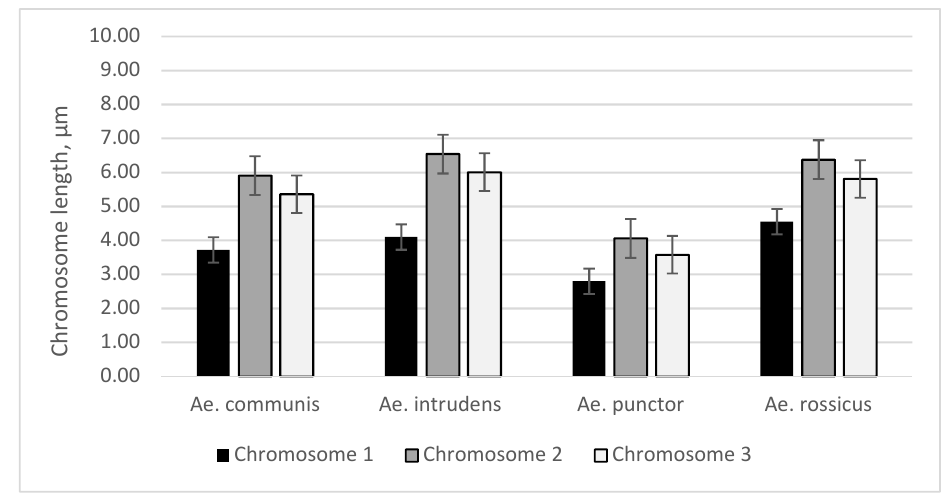
Figure 1. Mean lengths of metaphase chromosomes of Ae. communis , Ae. punctor , Ae. intrudens , and Ae. rossicus mosquitoes (µm); standard error bar (SE).